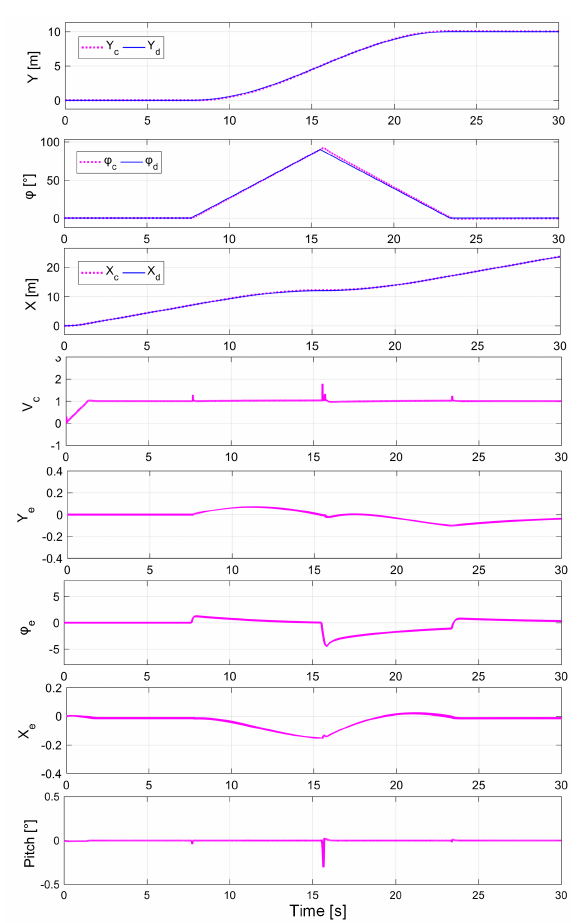
Figure 13. The tracking performances of the NMPC approach in lateral position, yaw angle, longitudinal position, rollator speed, lateral error, yaw error, longitudinal error, and pitch